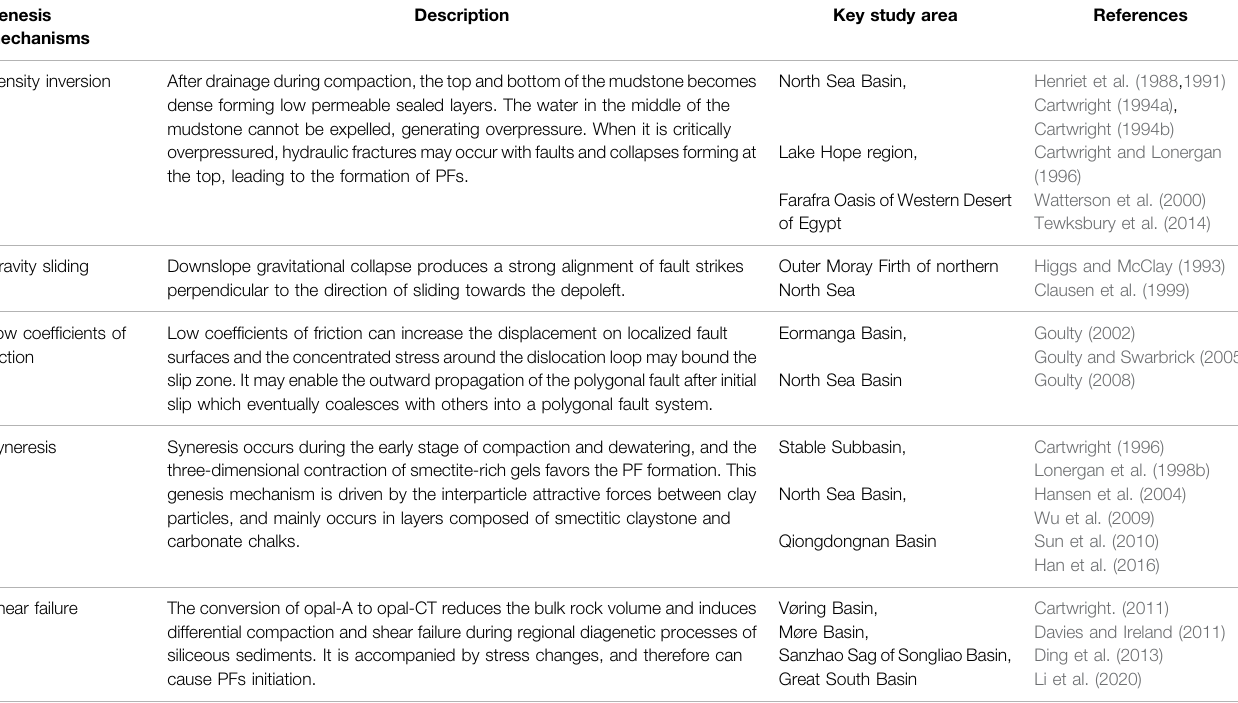
TABLE 1 | A compilation of genesis mechanisms of polygonal faults in different study